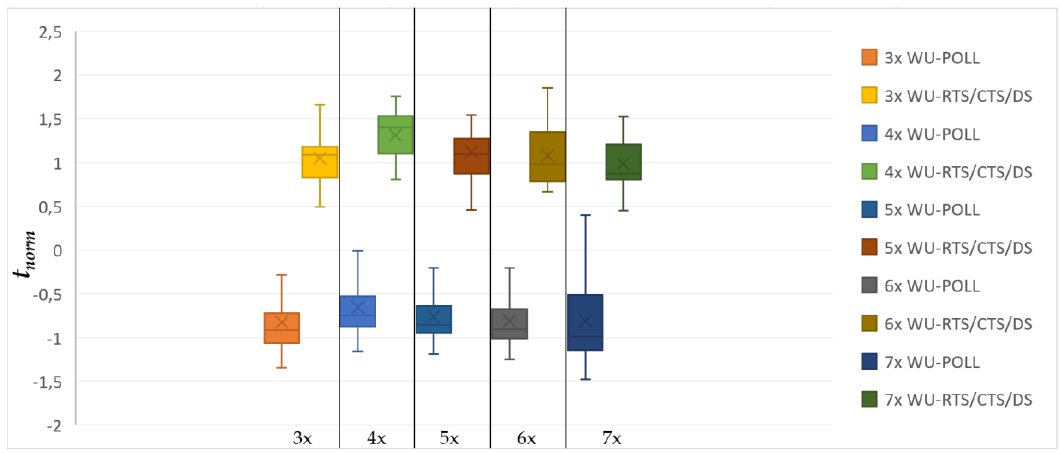
Figure 8. WU-RTS/CTS/DS and WU-POLL comparison (X: Δx: number of nodes per the hop; Y: t norm ). Figure 8. WU-RTS / CTS / DS and WU-POLL comparison (X: ∆ x: number of nodes per the hop; Y: t norm ).